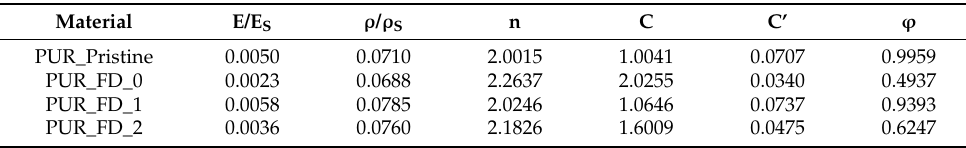
Table 5. Outcomes from Gibson–Ashby model of studied